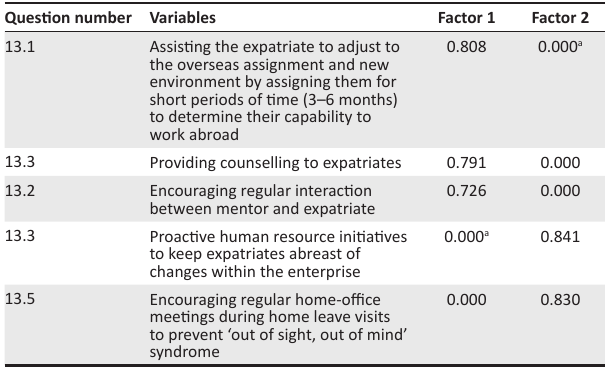
TABLE 3: Factor matrix with sorted rotated factor loadings.